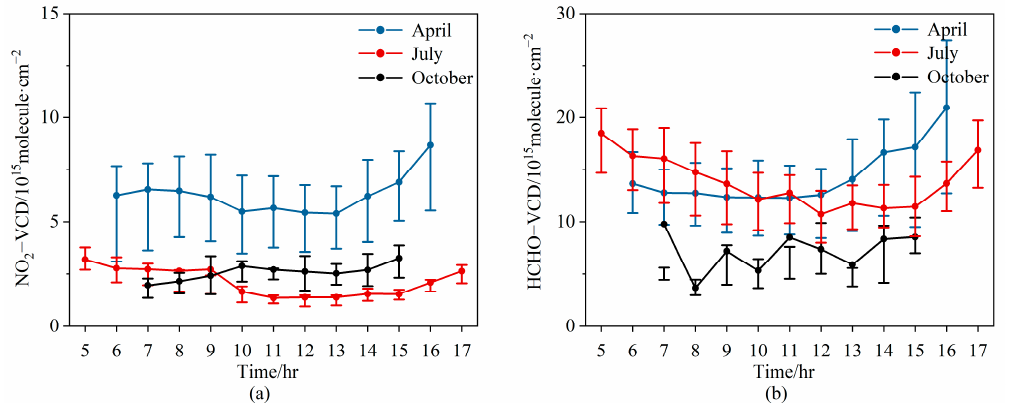
Figure 7. Diurnal variations of tropospheric VCDs for ( a ) NO 2 and ( b ) HCHO. The dots denote the averages, and the error bars represent the 25th and 75th percentiles of the data grouped for each hour. The blue, red, and black dotted lines denote April, July and October 2021, respectively.